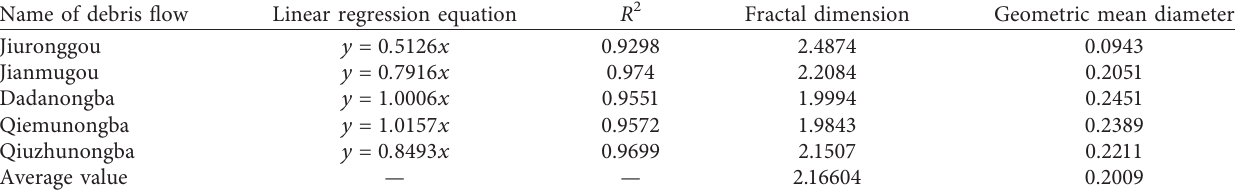
Table 2: Comparison of fractal dimensions and geometric mean diameters.